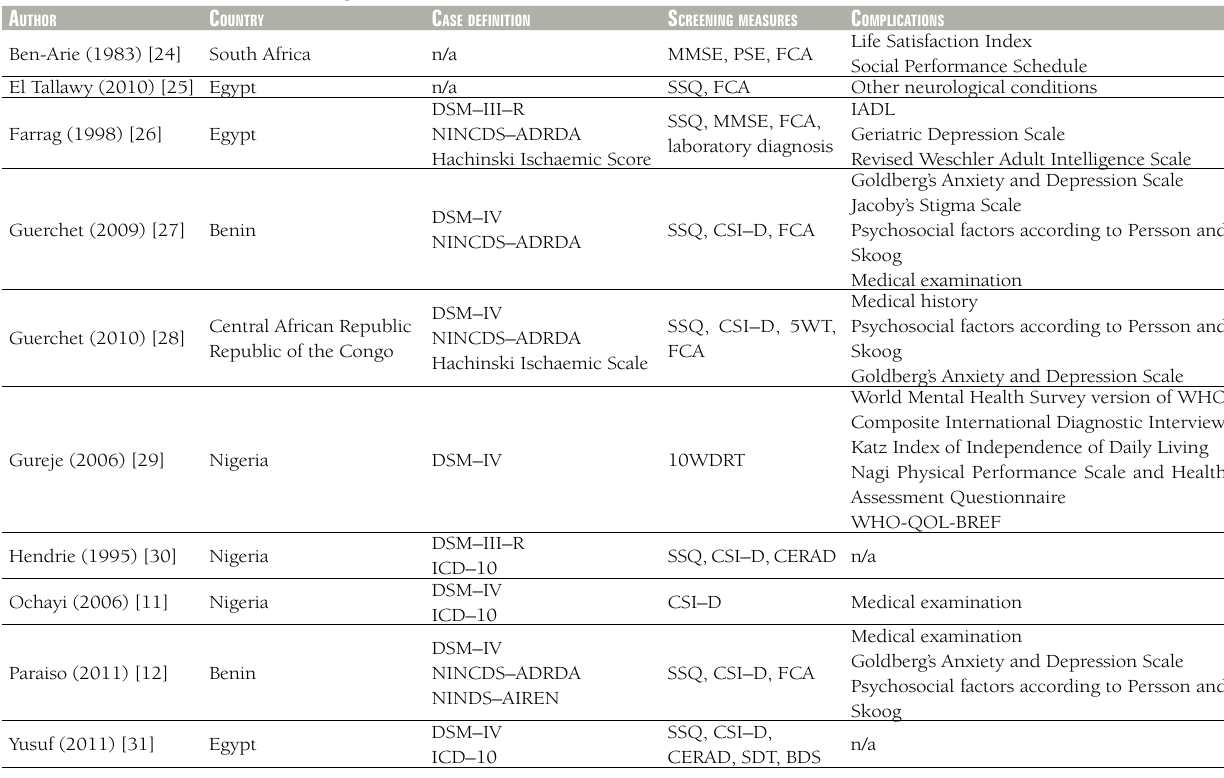
Table 3 Case definitions and screening measures of dementia in retained studies a uthor C